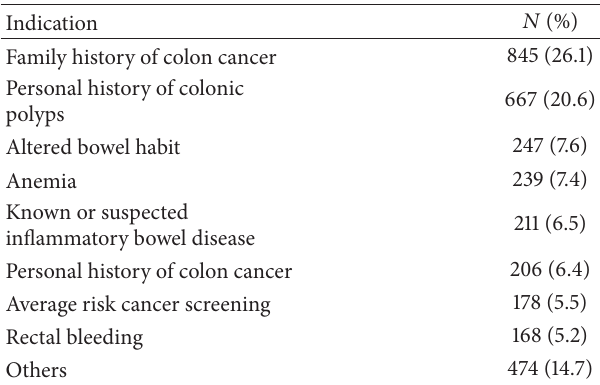
Table 1: Indications for